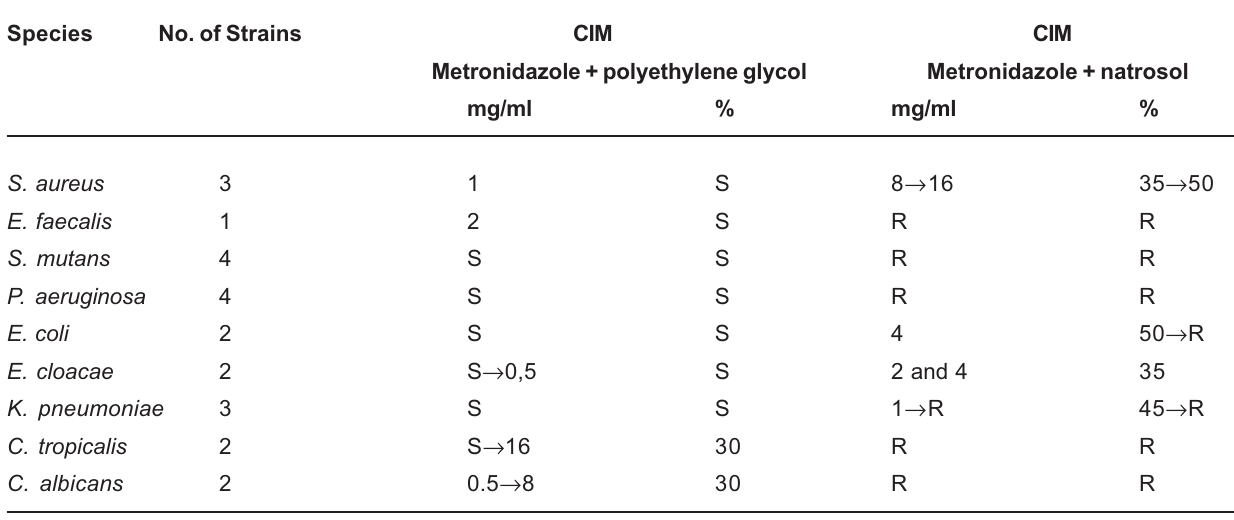
TABLE 4- Variation in MIC of the association of metronidazole (0.25 to 16 µ g/ml) with polyethylene glycol (25 to 50%) and metronidazole (0.25 to 16 µ g/ml) with natrosol (25 to 50%) for the tested